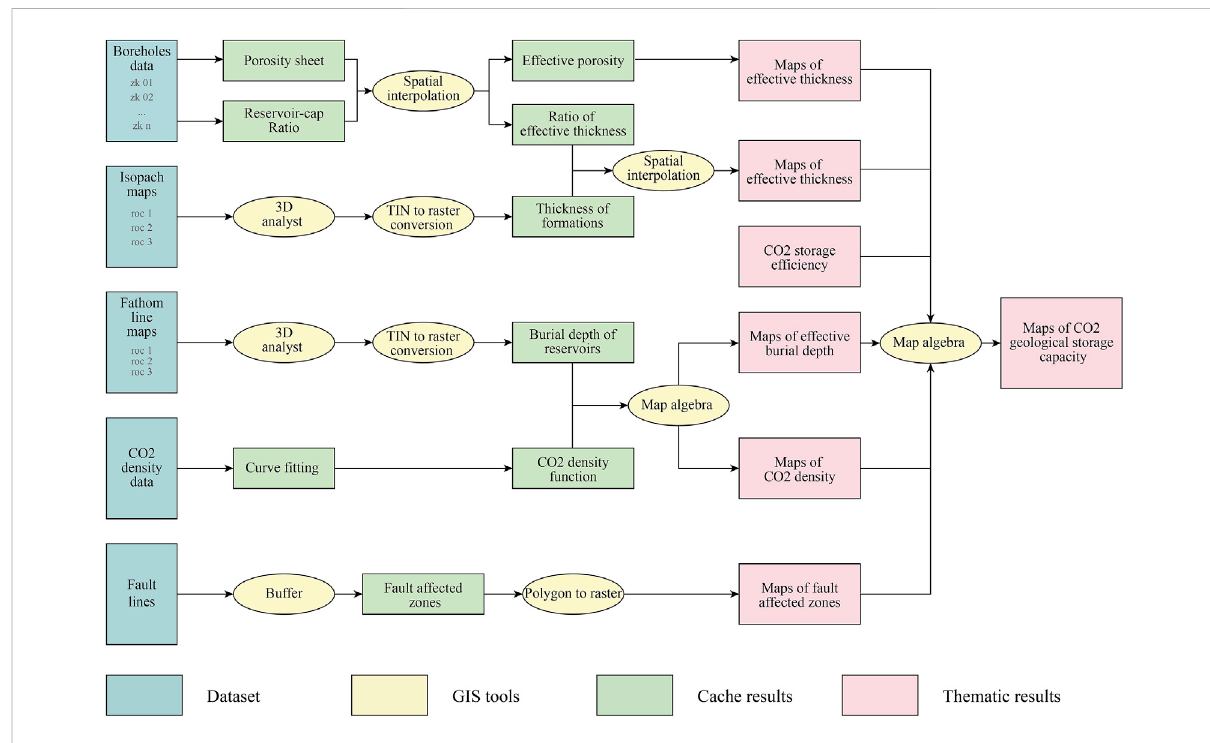
FIGURE 8 Automatic modeling diagram of CO 2 geological storage potential evaluation based on